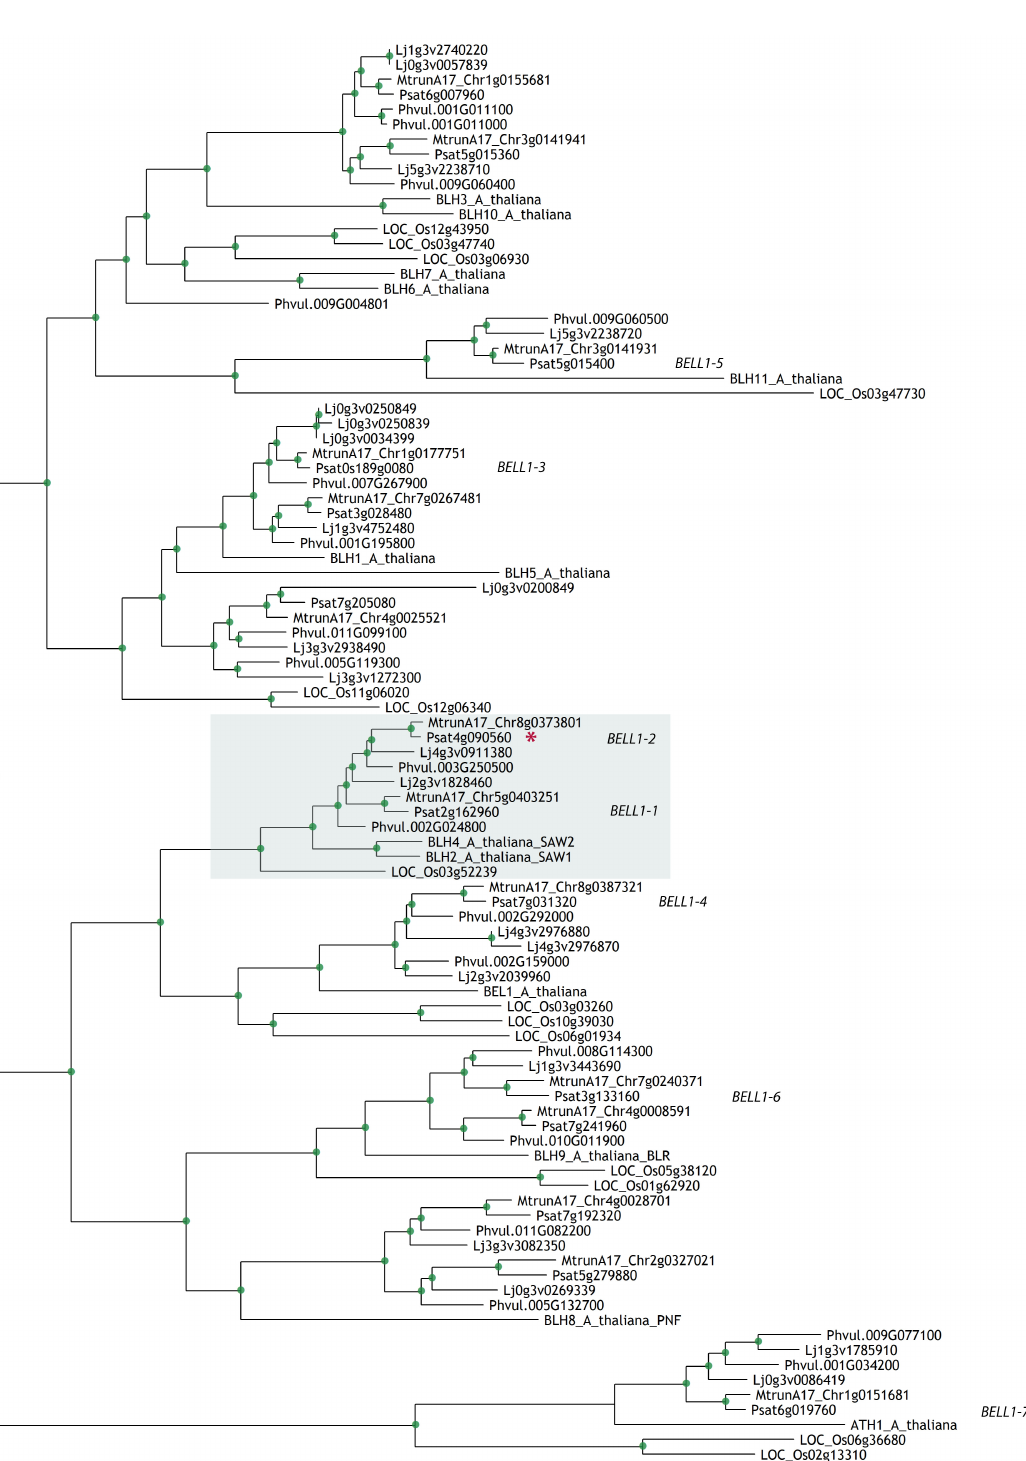
Figure 1. Phylogenetic tree constructed by the maximum-likelihood method based on amino acid sequences of BELLs from Arabidopsis thaliana , rice Oryza sativa and legumes: Medicago truncatula, Pisum sativum, Lotus japonicus, and Phaseolus vulgaris . Green dots indicate support more than 70 based on 1000 bootstrap replicates. Red asterisk indicates the gene of